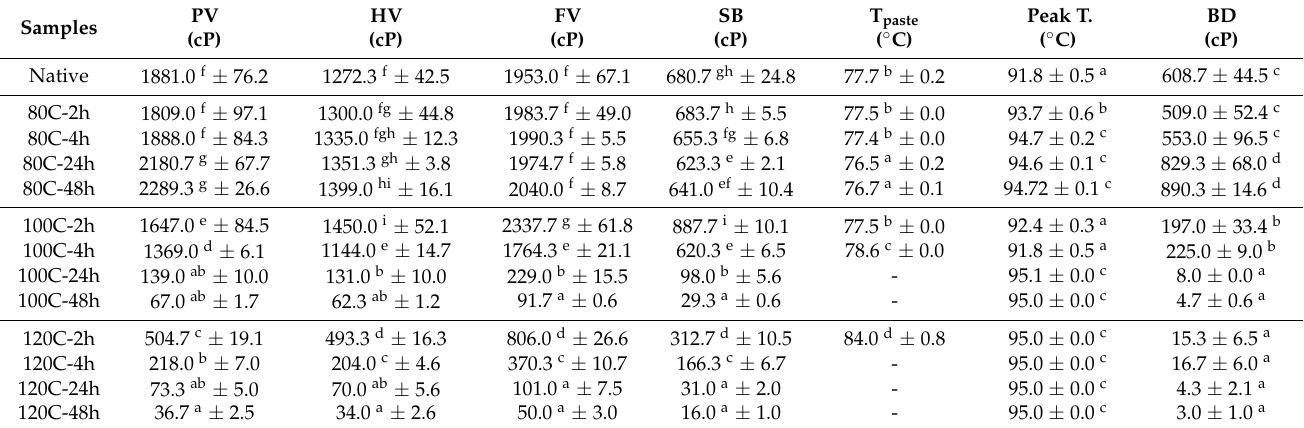
Different letters in the same column indicate statistically significant differences ( p <